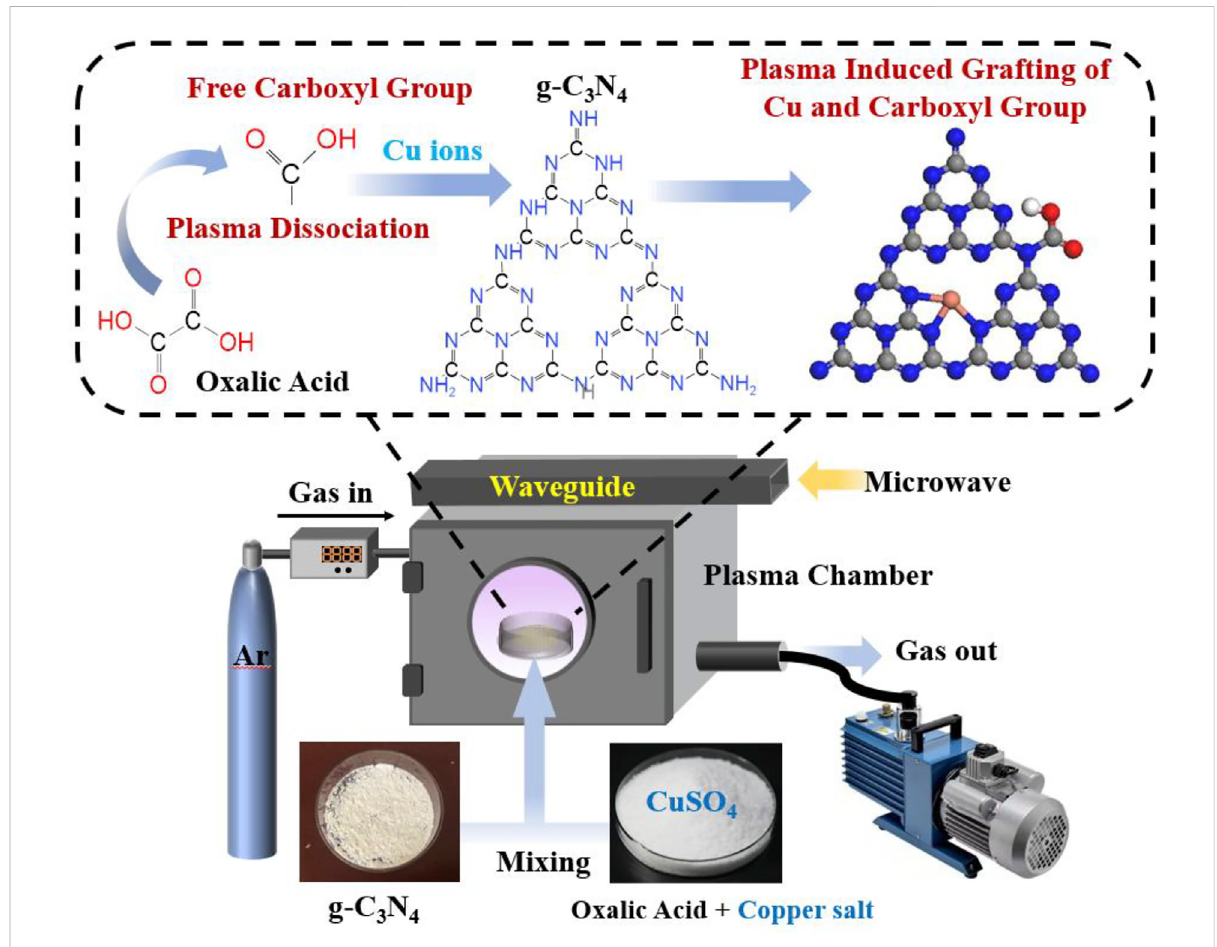
FIGURE 1 Schematic diagram of the plasma equipment used in this work and the molecular